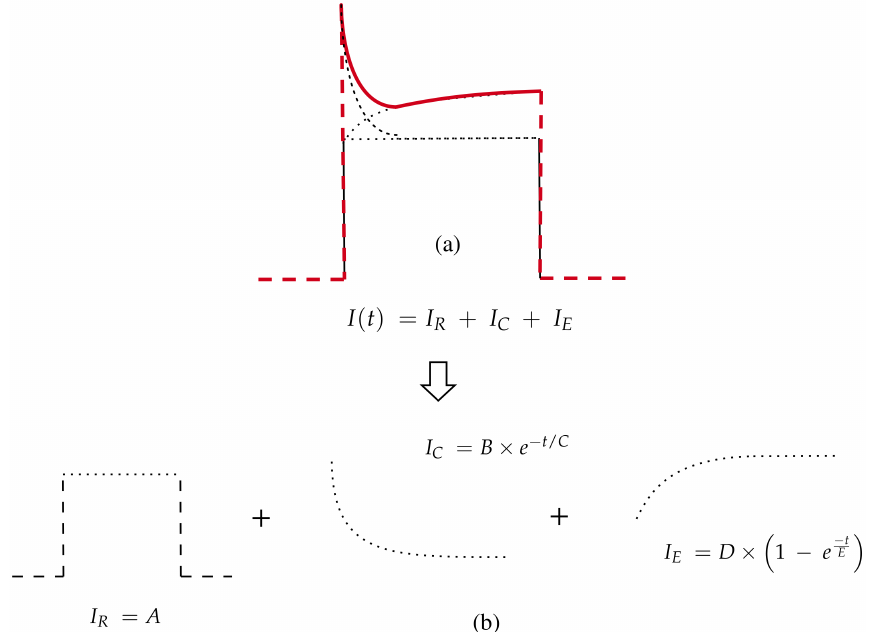
Figure 1. ( a ) Typical time course during PEF application to the tissue (red) and three mathematical functions (black); ( b ) Current is modeled as a sum of a square wave pulse and two exponential functions, by following the equation (Equation